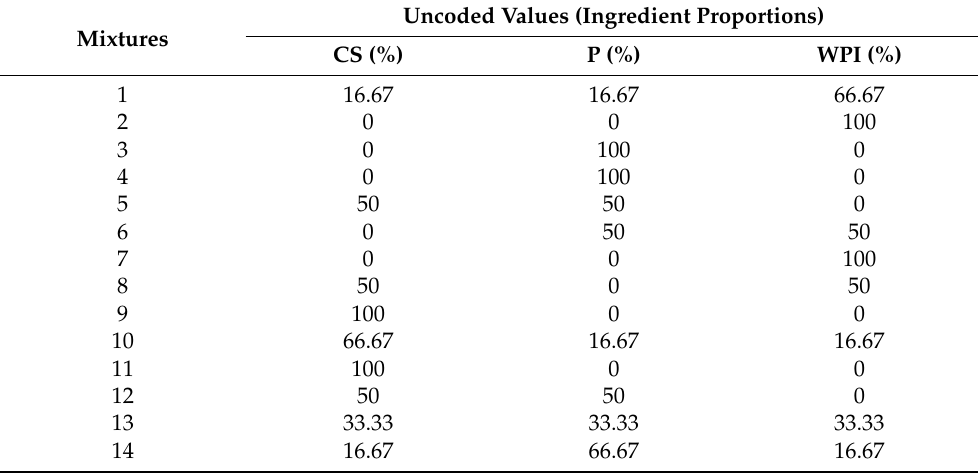
Table 1. Experimental design and mass fraction of three wall components according to simplex lattice mixture